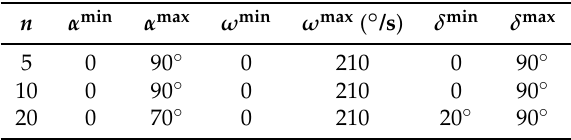
Table 2. Range of the parameters of the sinusoidal motion